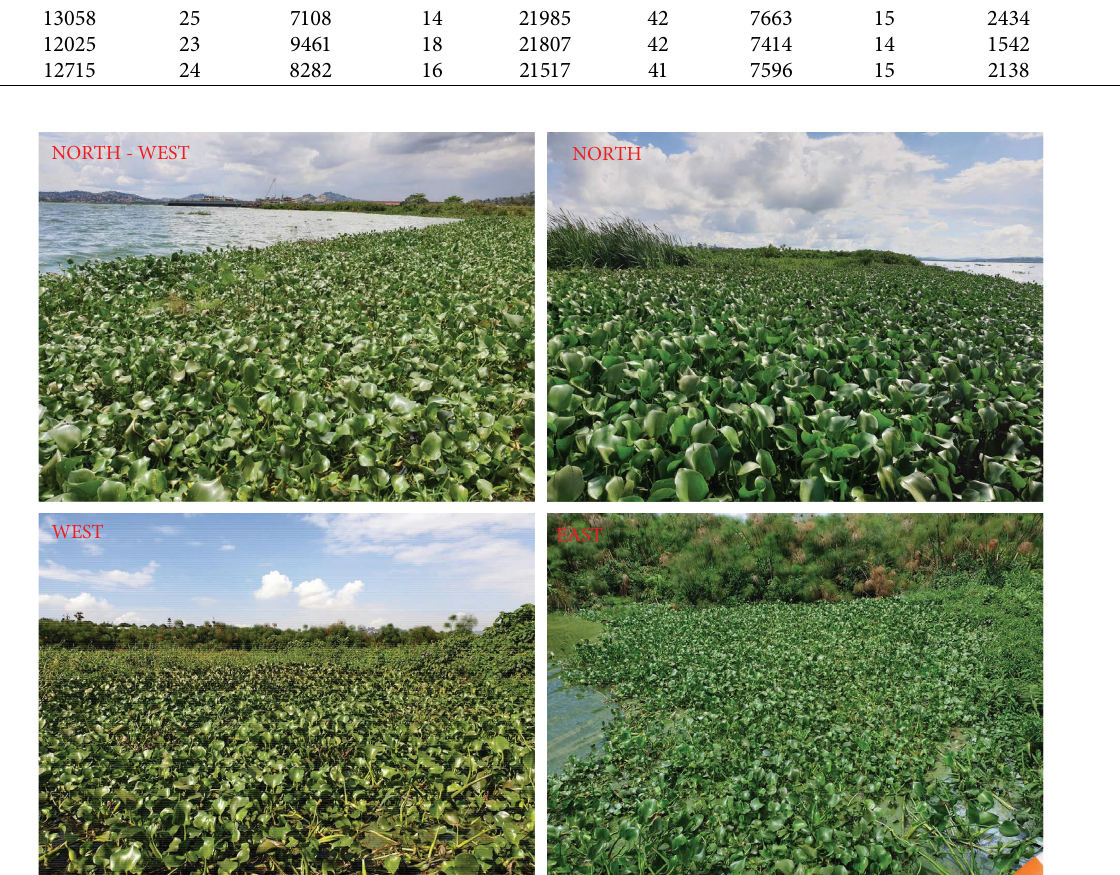
Figure 5: Distribution of the water hyacinth in the Murchison Bay (source: author,